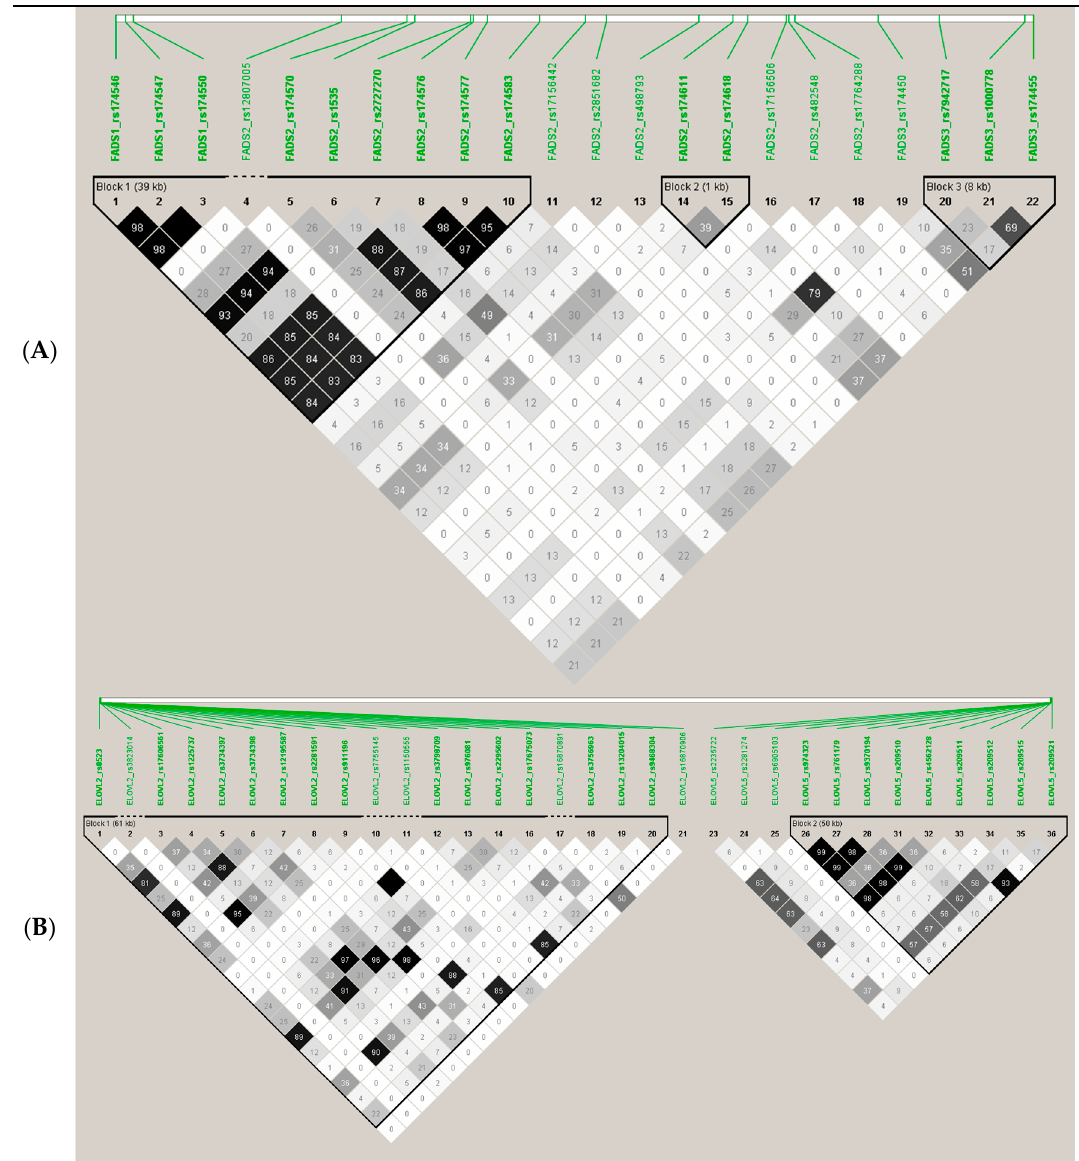
Figure 9. Genes, SNPs, and linkage disequilibrium (r2) among the SNPs selected for the regional-wide association studies (RWASs), based on previous knowledge of the relevance of this region for the associations between its SNPs and PUFA concentrations: ( A ) region containing all the SNPs in/near the cluster FADS1 / FADS2 / FADS3 (chromosome 11) in the Illumina HumanOmniexpress array; ( B ) region containing all the SNPs in/near the cluster ELOV2 - ELOV5 (chromosome 6) in the Illumina HumanOmniexpress array.